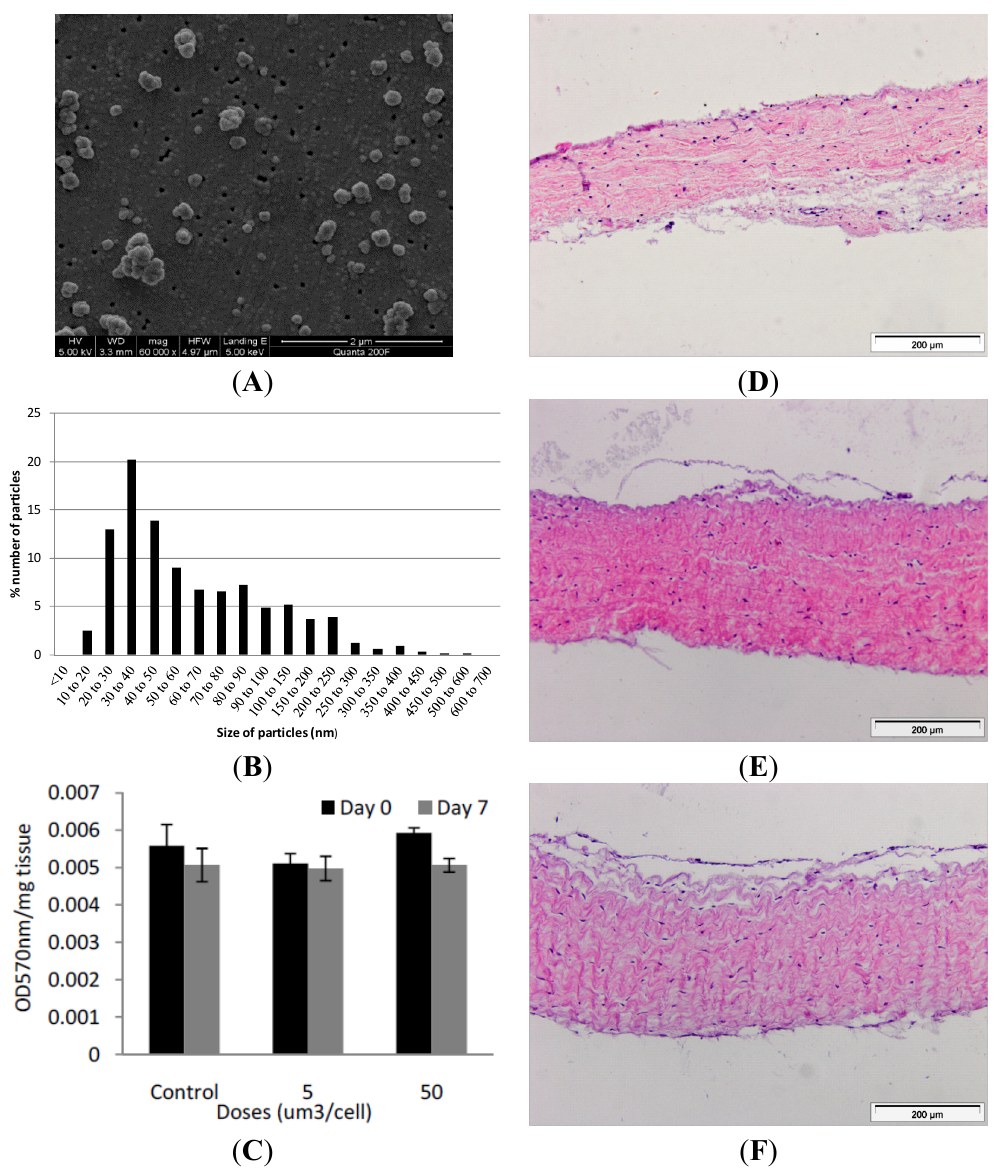
Figure 2. ( A ) Representative image of cobalt-chrome nanoparticles that were generated using a pin-on-plate tribometer. Images were captured by FEGSEM; ( B ) Size distribution of cobalt-chrome nanoparticles. The size distribution of the cobalt-chrome nanoparticles was determined from SEM images taken from different locations on the filter membrane and analysed using Image Pro-Plus imaging software; ( C ) Effects of CoCr nanoparticles on the viability of dura-mater at 0 and 7 days of culture. Porcine dura mater tissue was cultured in the absence (control) and presence of CoCr nanoparticles at an estimated dose of 5 and 50 µm 3 per epithelial cell and viability determined by the MTT assay. Data are expressed as the mean ( n = 3) ± 95% confidence limits. The data were analysed by ANOVA which revealed no significant variation between control and CoCr-treated tissues at day 0 or day 7. Images of dura mater tissue exposed to cobalt-chrome nanoparticles at an estimated dosage of 0 ( D ), 5 ( E ) and 50 ( F ) µm 3 per epithelial cell for a period of 7 days and stained with H&E. Tissues sections shown are orientated so that the outer epithelial layer is closest to the top of the